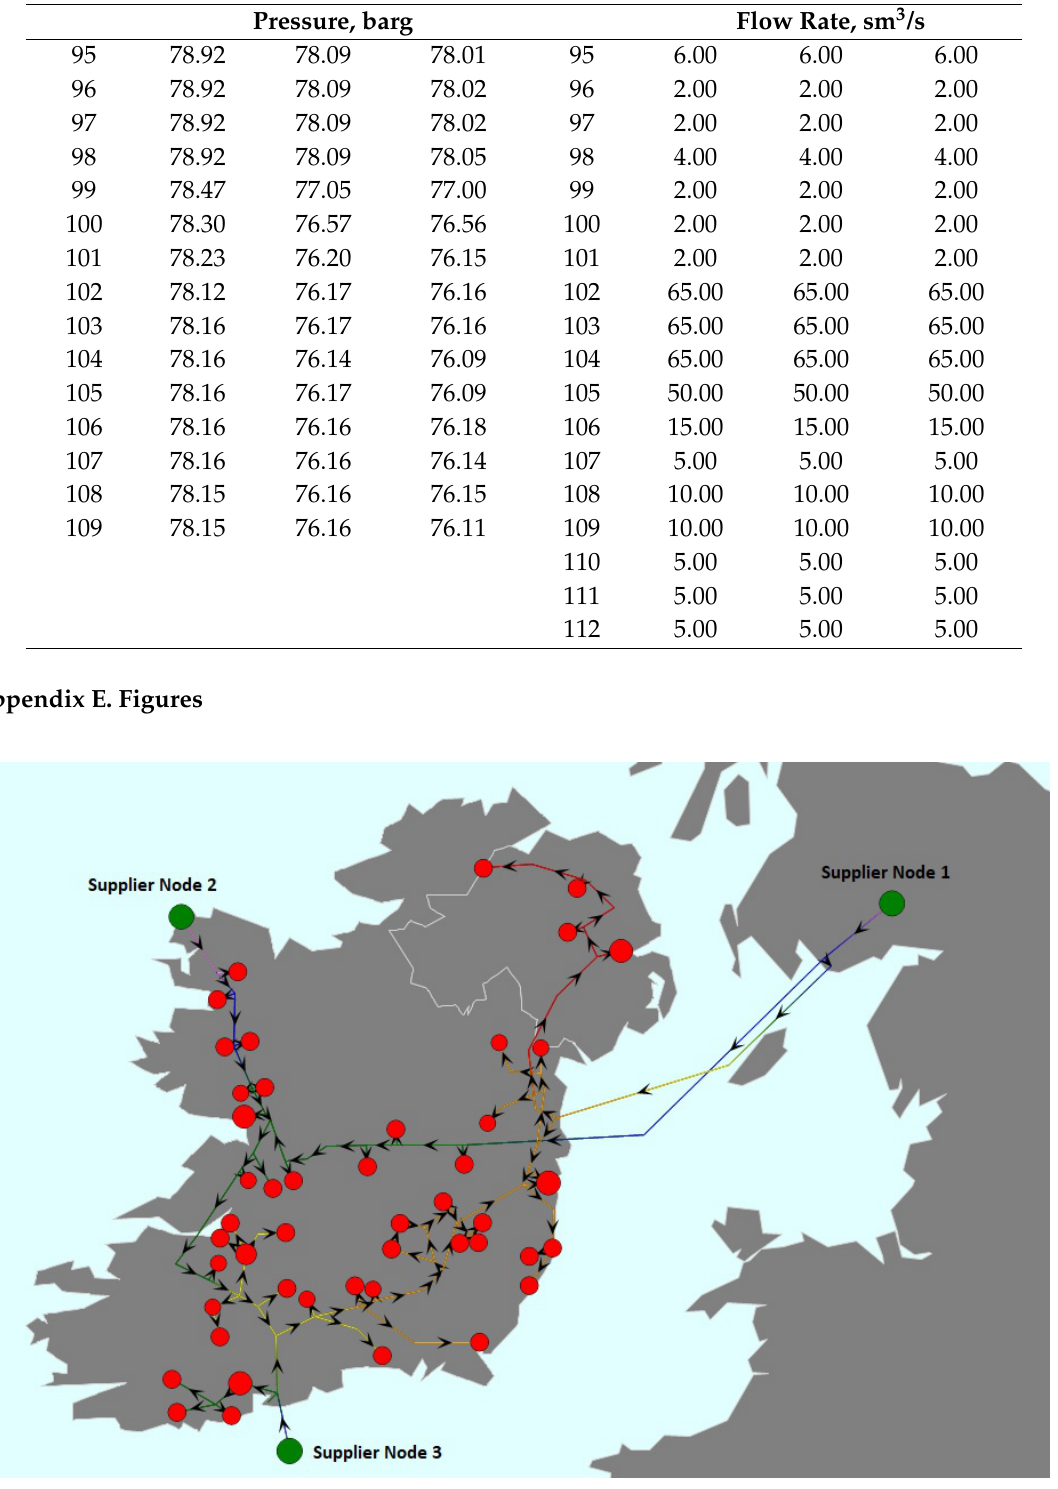
Figure A1. The 109-node map of Ireland’s gas